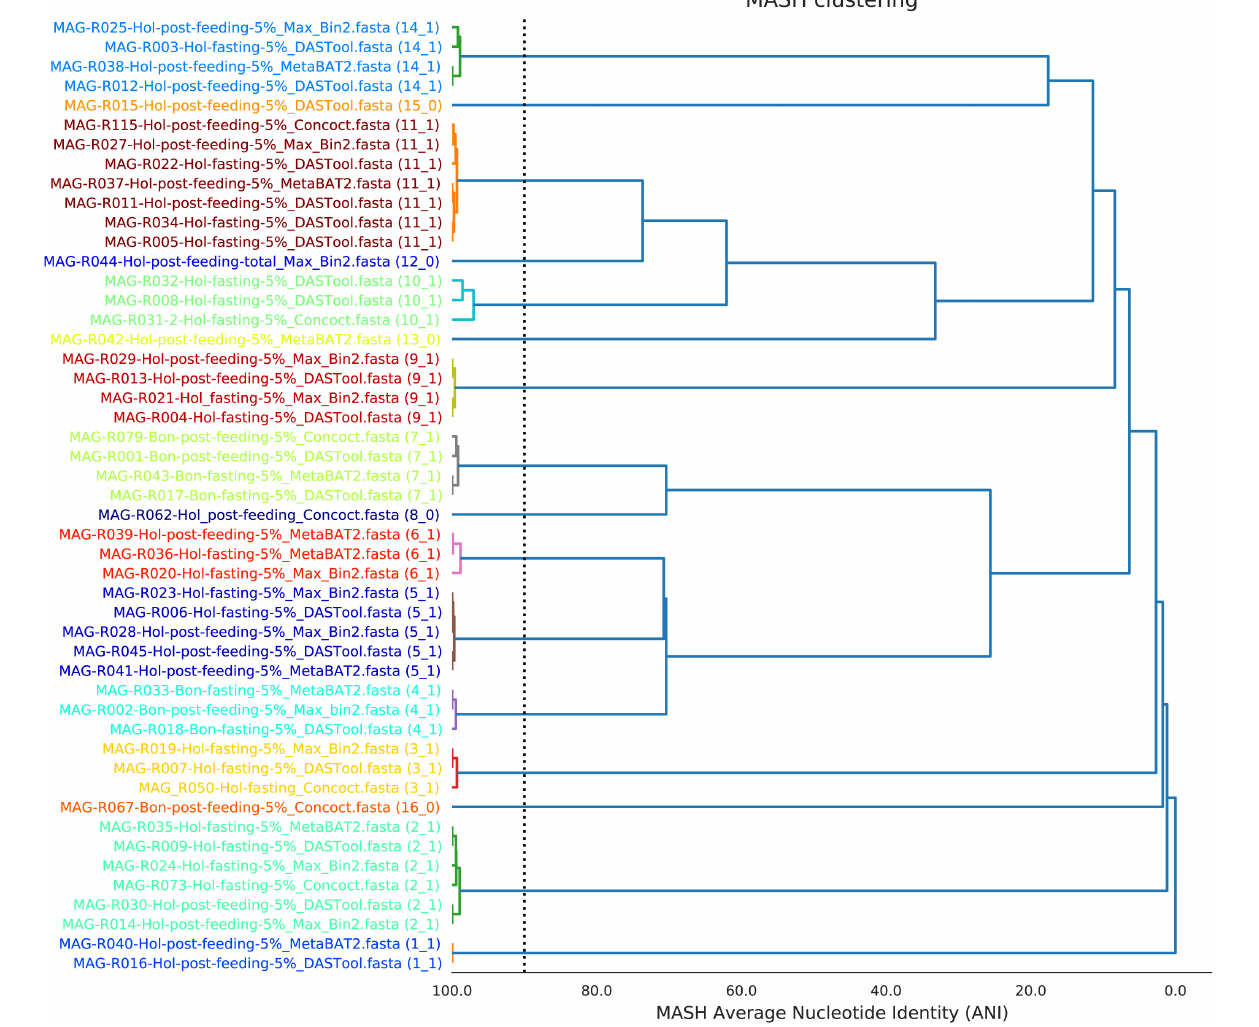
Frontiers in Microbiology |